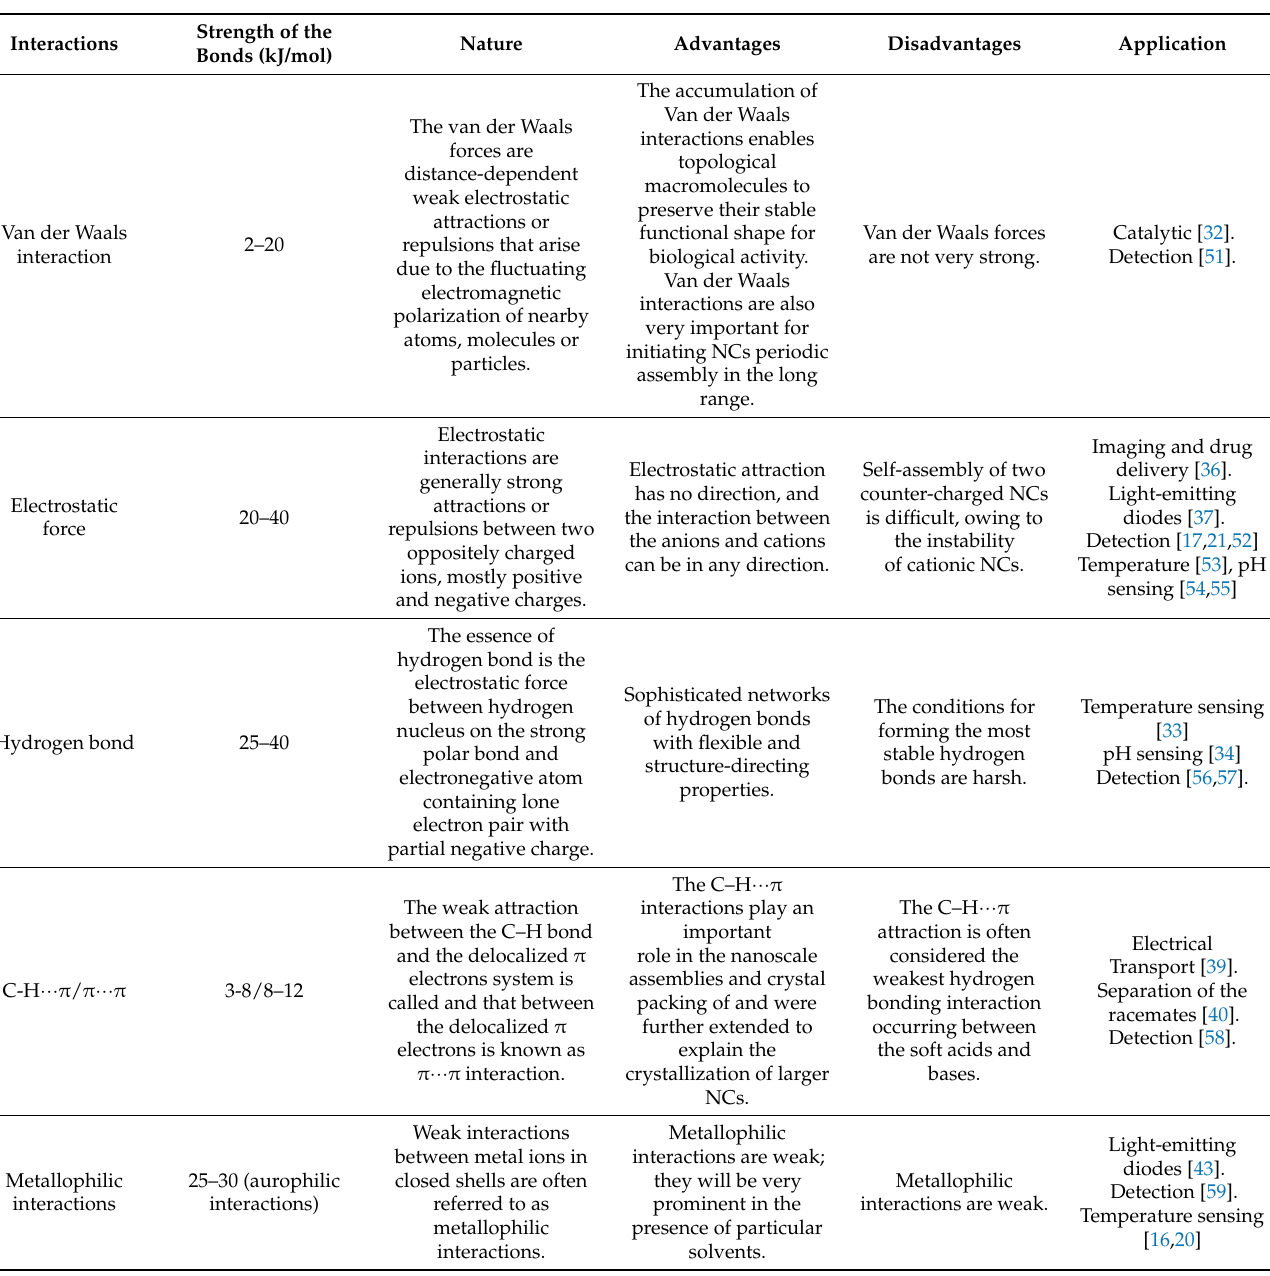
Table 1. The assembly mechanism of coinage metal